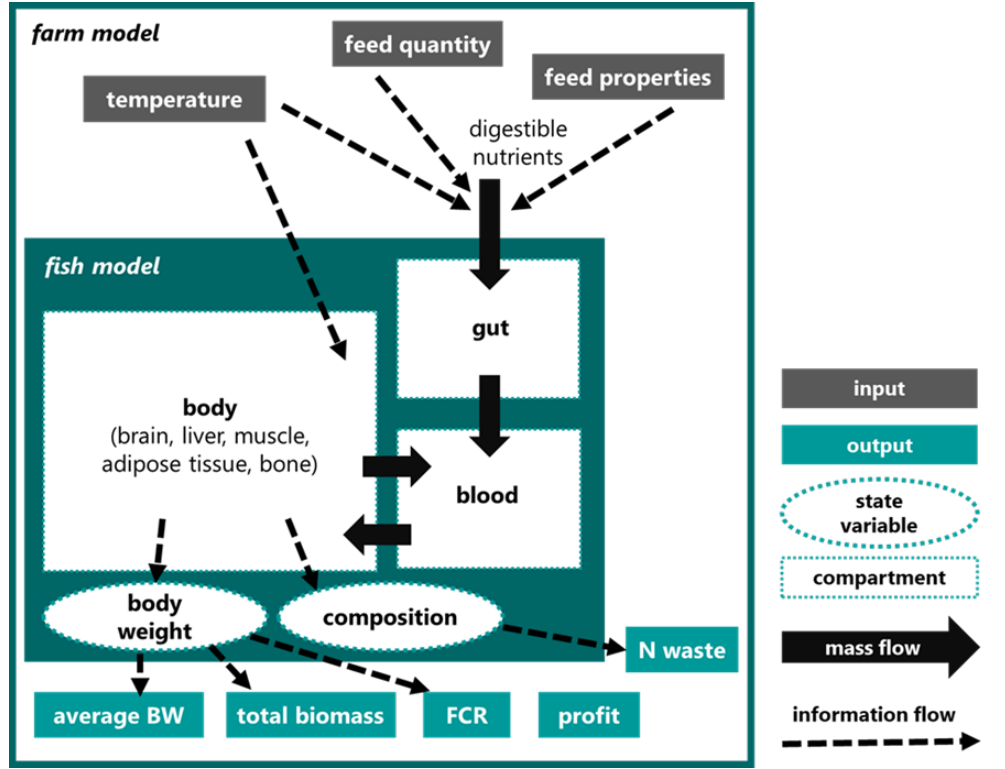
Figure A1. Diagram detailing a simplified high-level structure of FEEDNETICS, with emphasis on the fish model component. Inputs to the fish model (previously pre-processed by the farm model ) drive its time-dependent behavior, while its state variables are used in the calculation of all outputs (only a small subset of which are depicted in the diagram). Each compartment contains a set of mass pools (not depicted) which represent the amount of each metabolite in each compartment.